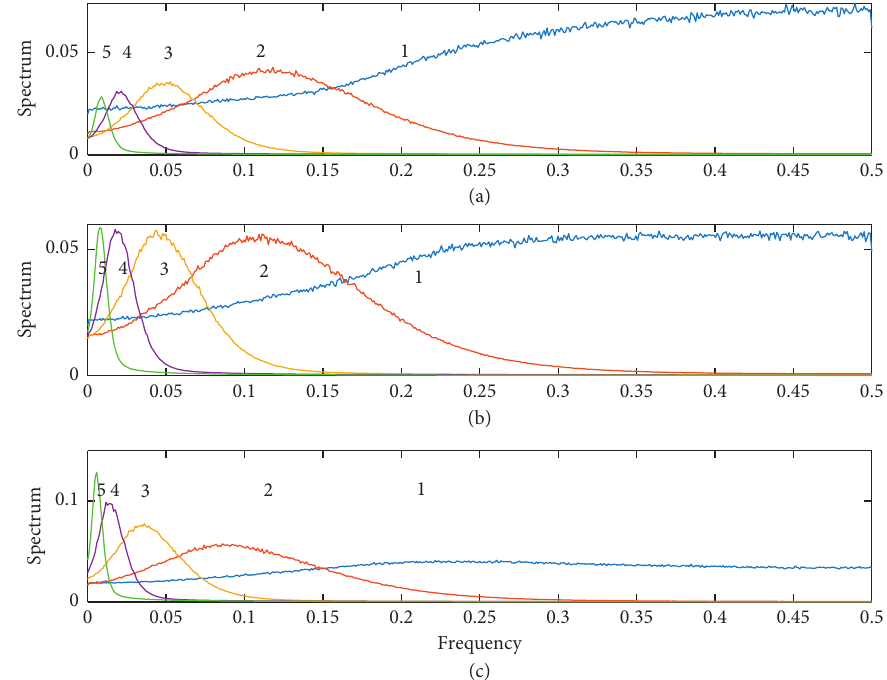
Figure 2: The averaged Fourier spectra of IMFs for EMD realizations, in the case of three typical Hurst exponents: (a) H � 0.2, (b) H � 0.5, and (c) H � 0.8.